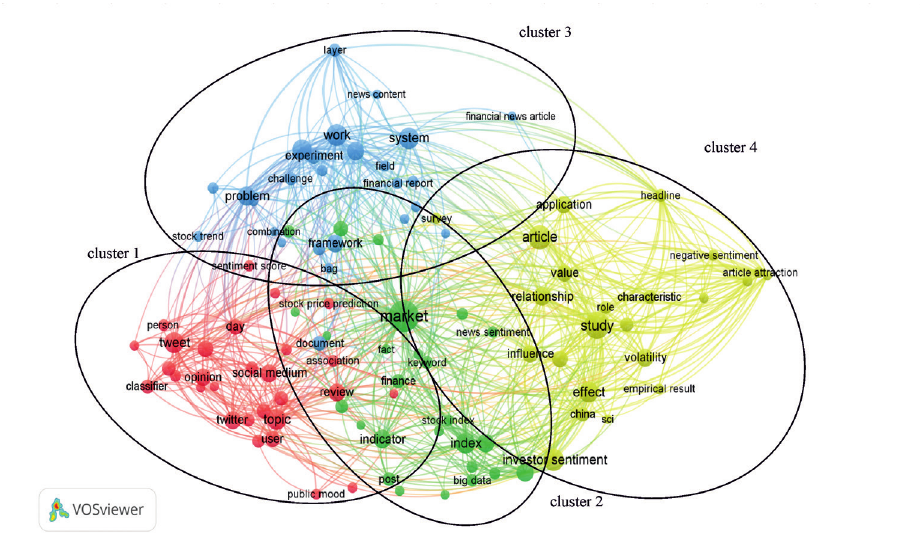
Figure 2. Results of bibliometric keyword occurrence